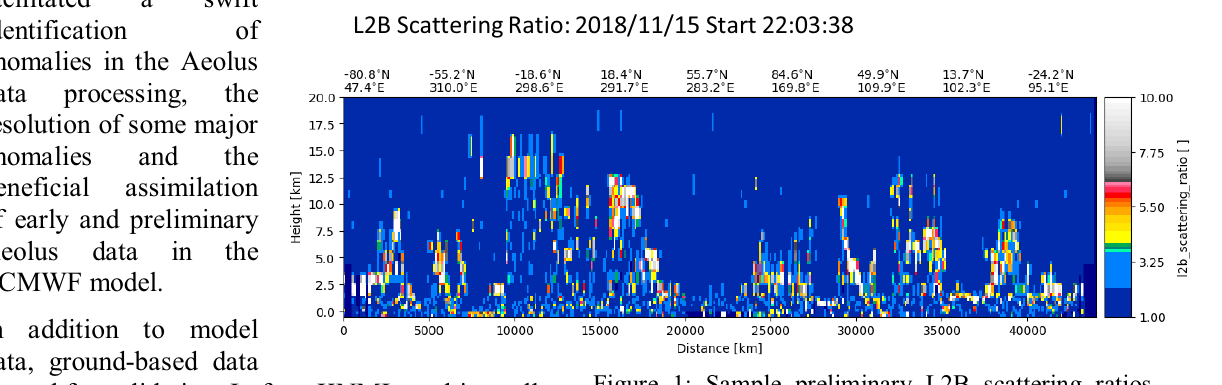
Figure 1: Sample preliminary L2B scattering ratios estimates (derived from Rayleigh